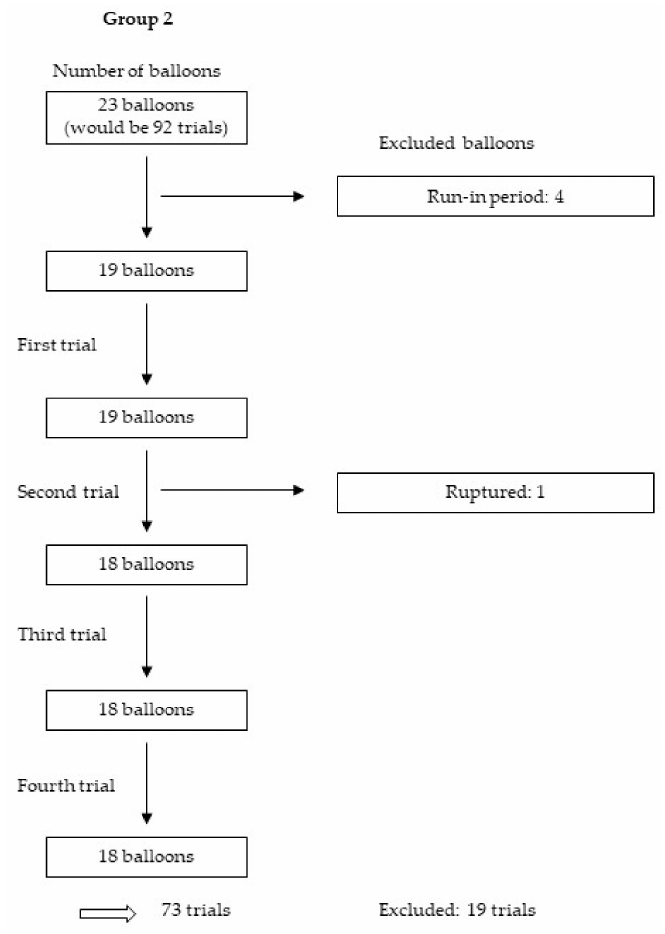
Figure 6. Excluded balloons group